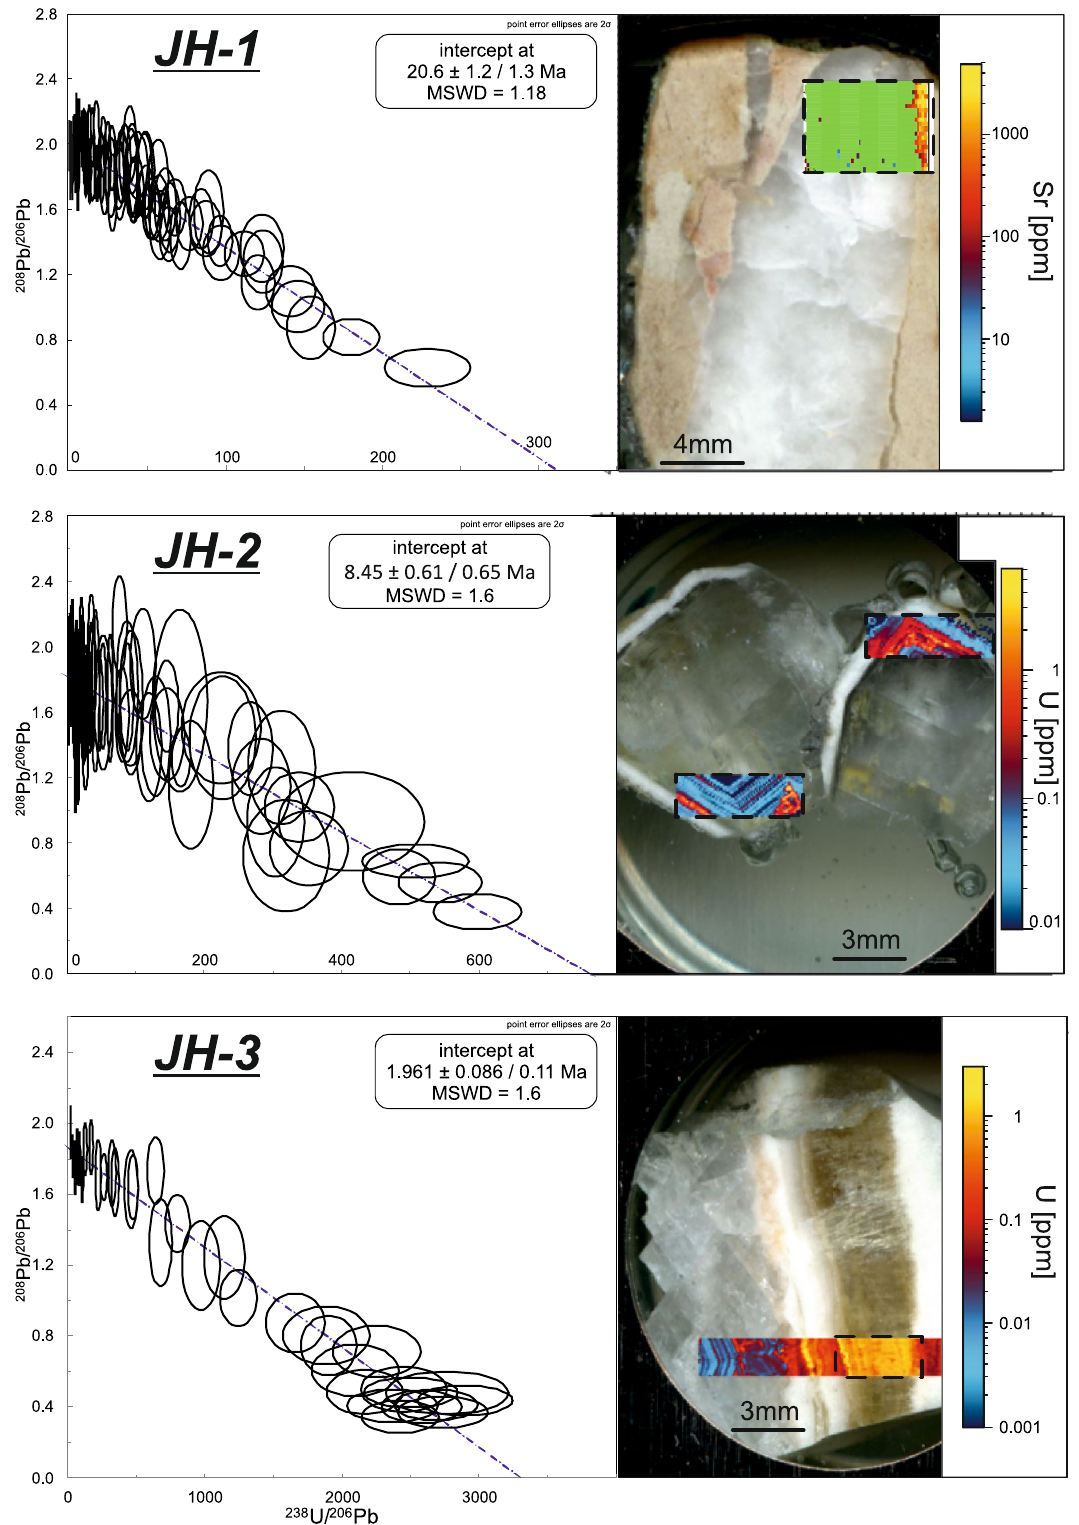
Figure 5:. 208 Pb/ 206 Pb vs 238 U/ 206 Pb age plots (86-TW space) of samples JH-1, JH-2 and JH-3. The elemental concentration maps (strontium and uranium ppm) are superimposed on the vein cement images and denote the areas dated by